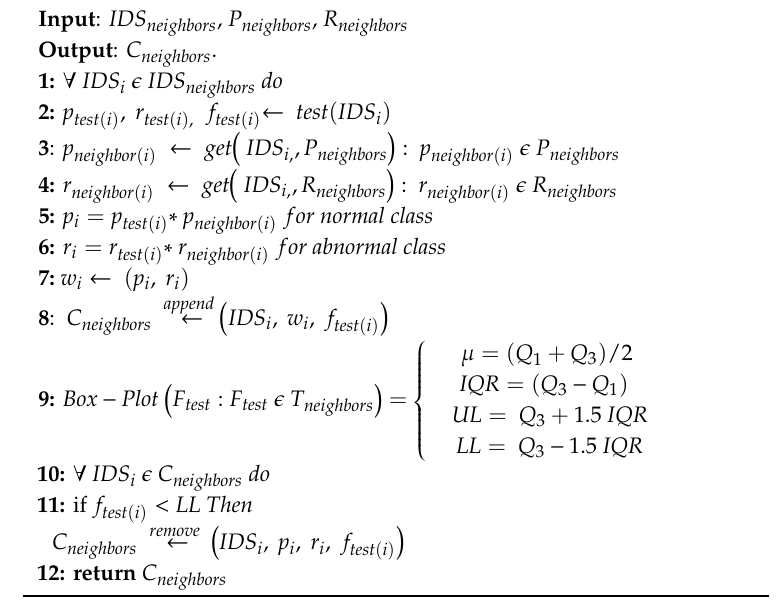
Algorithm 2: Misbehavior Evaluation Algorithm